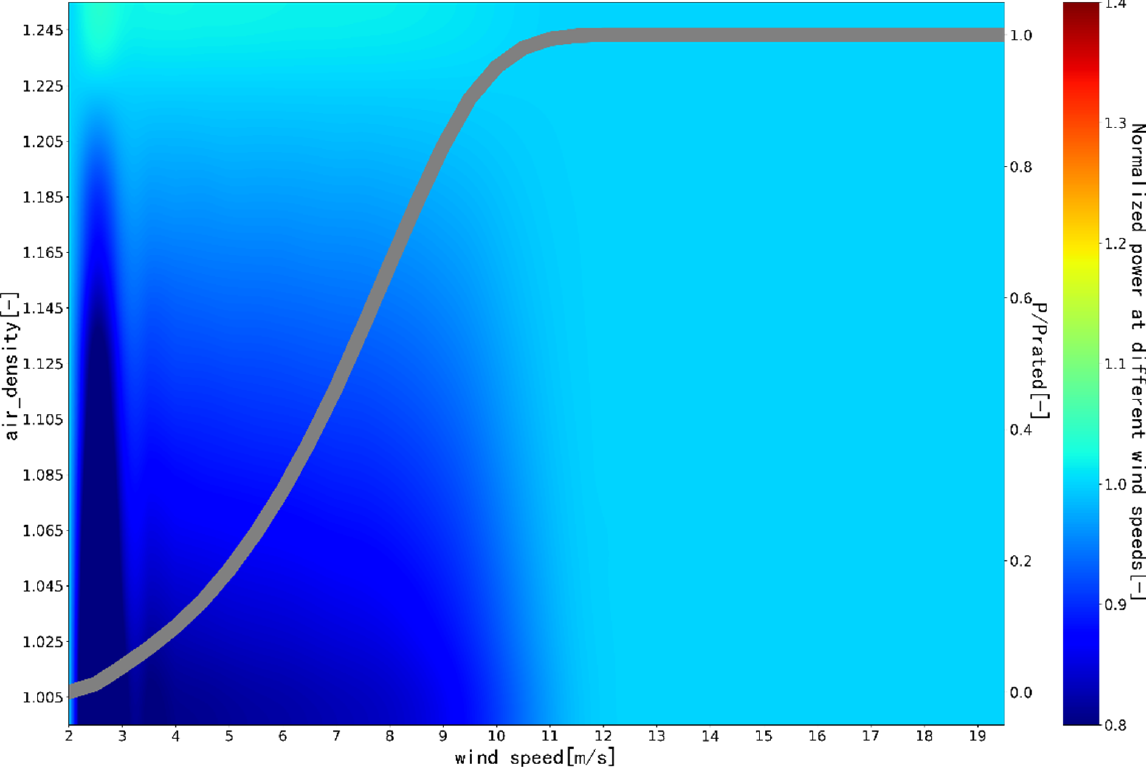
Figure 3. The effect of air density on WTG OP (color axis = normalized power at different wind speeds).